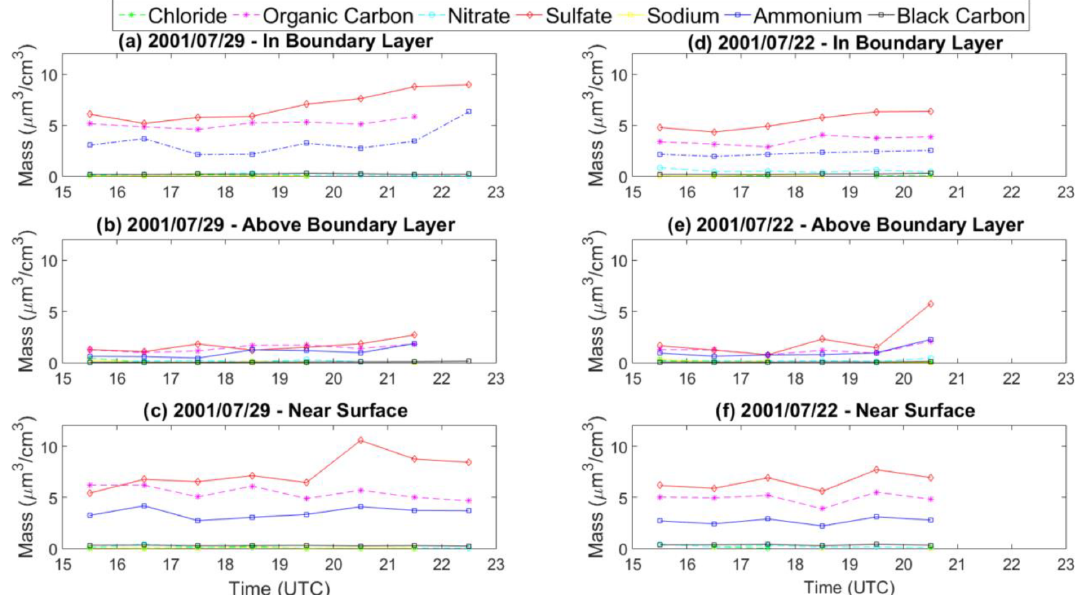
Figure 13. Hourly mean values total number of particles obtained by the SMPS, UHSAS and LAS instruments aboard the P-3B airplane and acquired on 29 and 22 July 2011. Data are presented for three different altitudes: near the surface (altitude below 1km), in the planetary boundary layer (1–2km for 29 July and 1–1.8km for 22 July) and above the planetary boundary layer ( > 2 . 0km for 29 July and > 1 . 8km for 22 July).